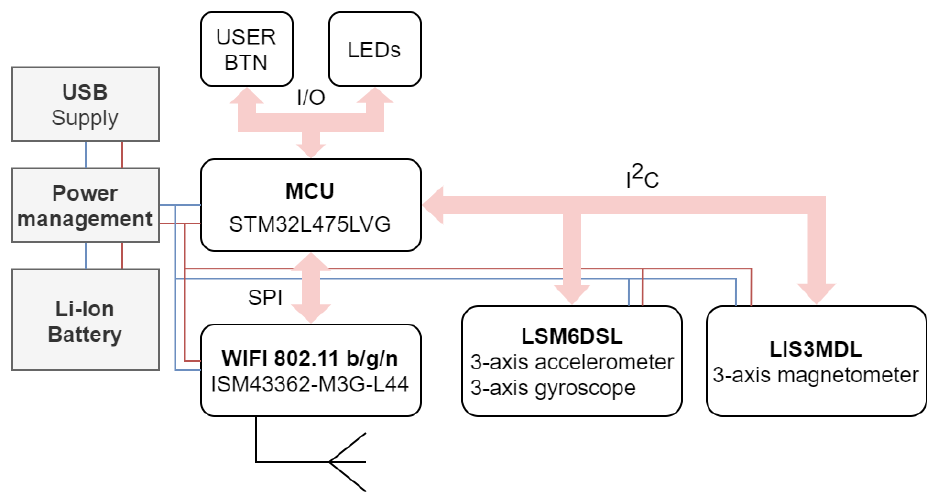
Figure 3. Hardware and communication architecture.